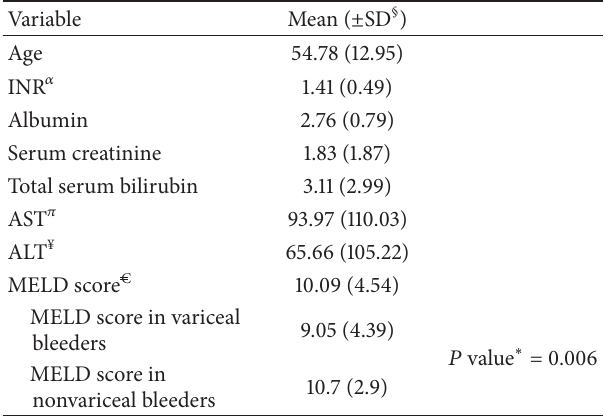
Table 3: Baseline demographic, biochemical, and liver disease severity scores among cirrhotic